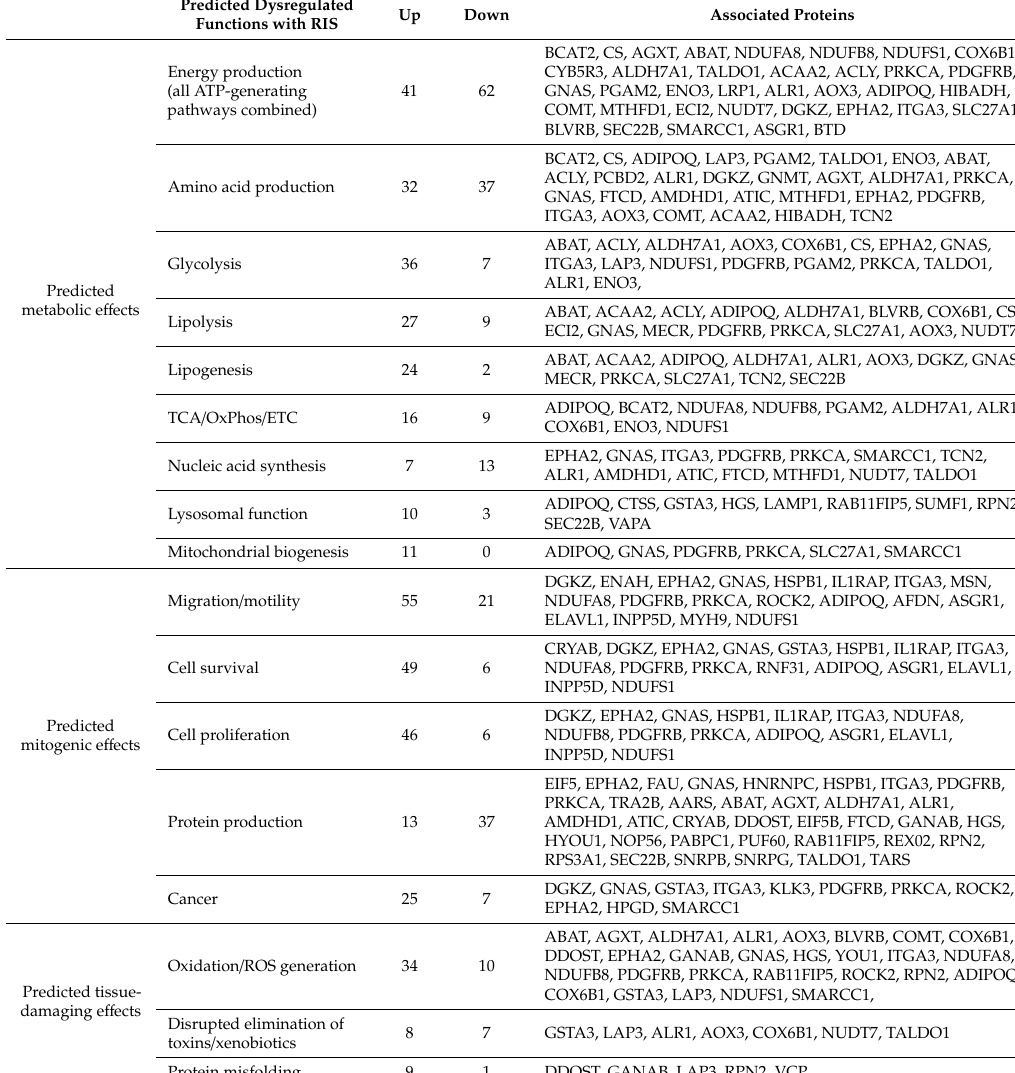
Table 1. Selected results from the KEGG function categories for di ff erentially expressed hepatic proteins from mice treated with risperidone.